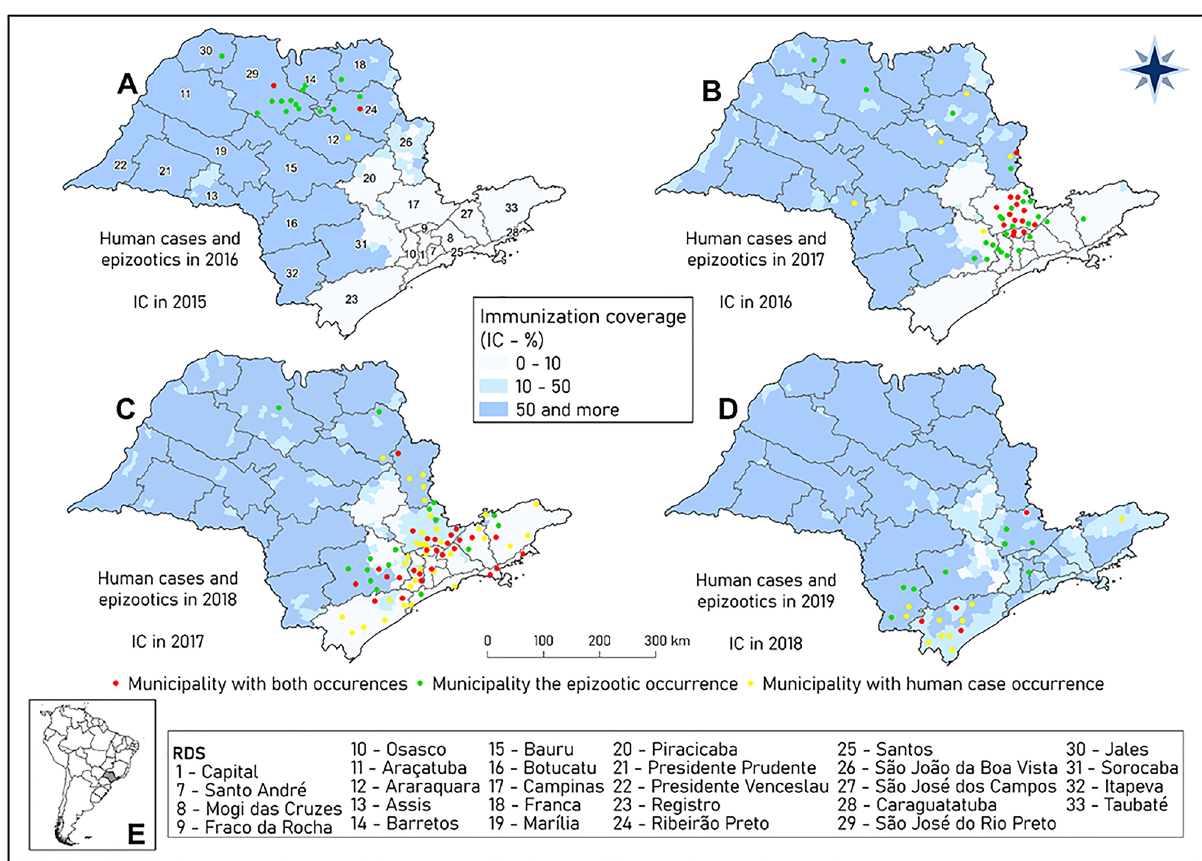
Figure 1. Maps of municipalities and Regional Disease Surveillance (RDS) with the occurrence of yellow fever (human autochthonous cases, epizootics and both) in 2016 ( A ), 2017 ( B ), 2018 ( C ) and 2019 ( D ) and, respectively, the vaccination coverages in the immediately preceding year, state of São Paulo. Map ( E ) presents the localization of the state of São Paulo in Brazil and South America. Maps created using the Free and Open Source